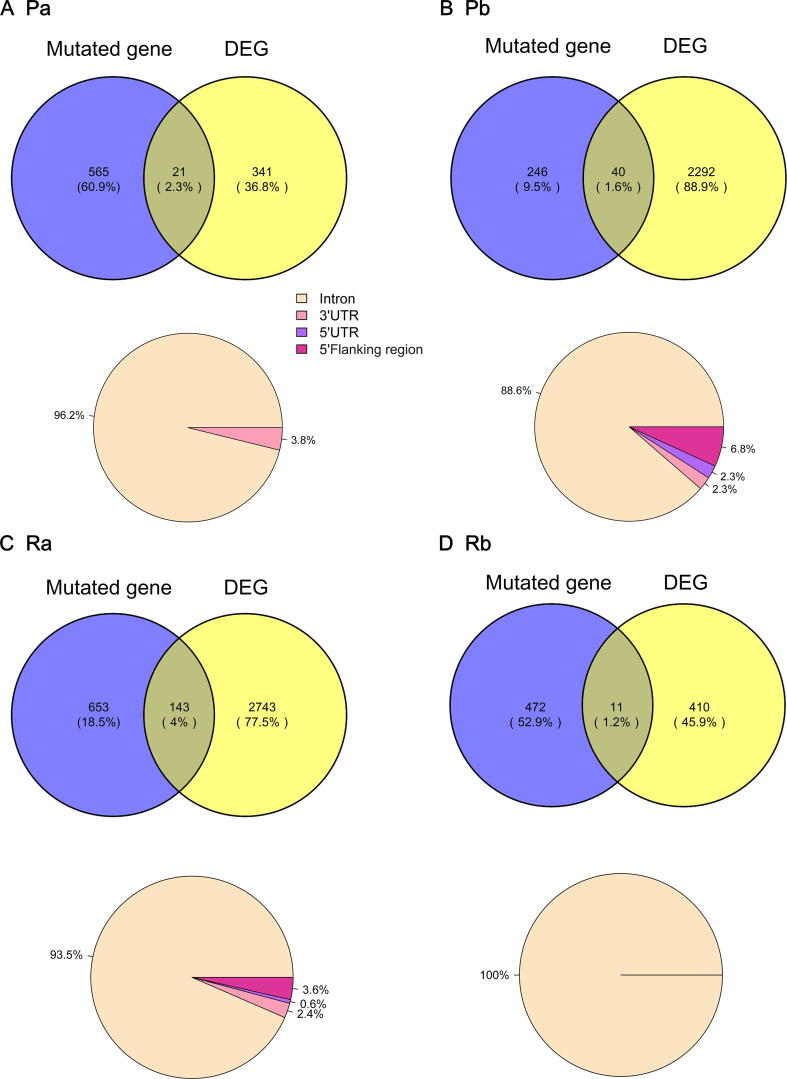
Overlap between sample-specific mutated genes and DEGs for each sample Overlap between sample-specific mutated genes and DEGs for Pa (A), Pb (B), Ra (C), and Rb (D). P values were derived from binomial test. The percentage of overlapping genes is significantly lower than the expectation (P < 2.2E–16 for all groups). The pie charts depict the locations of the gene mutations that overlapped with the DEGs in each sample.